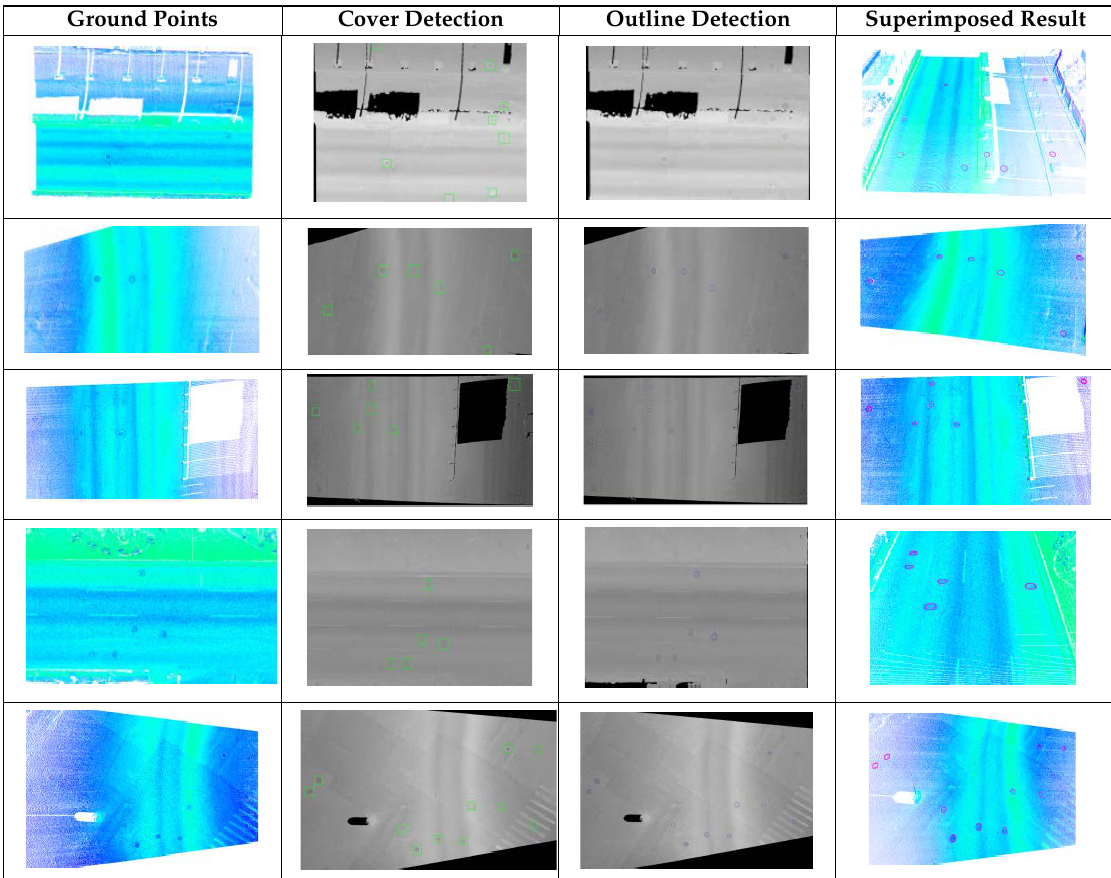
Table 2. Manhole cover detection results.